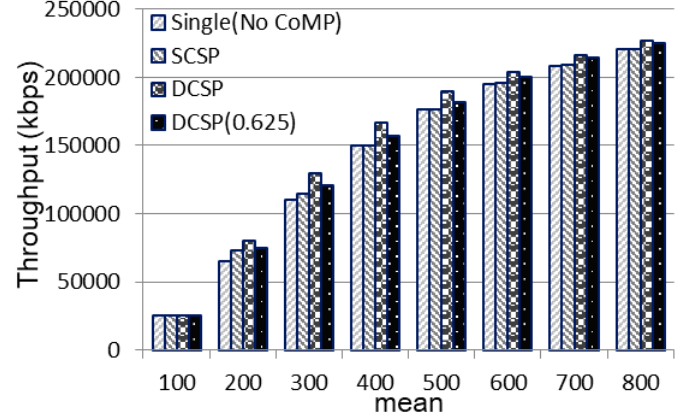
Figure 15. The effect of ᶆ on the total amount of used TTI.